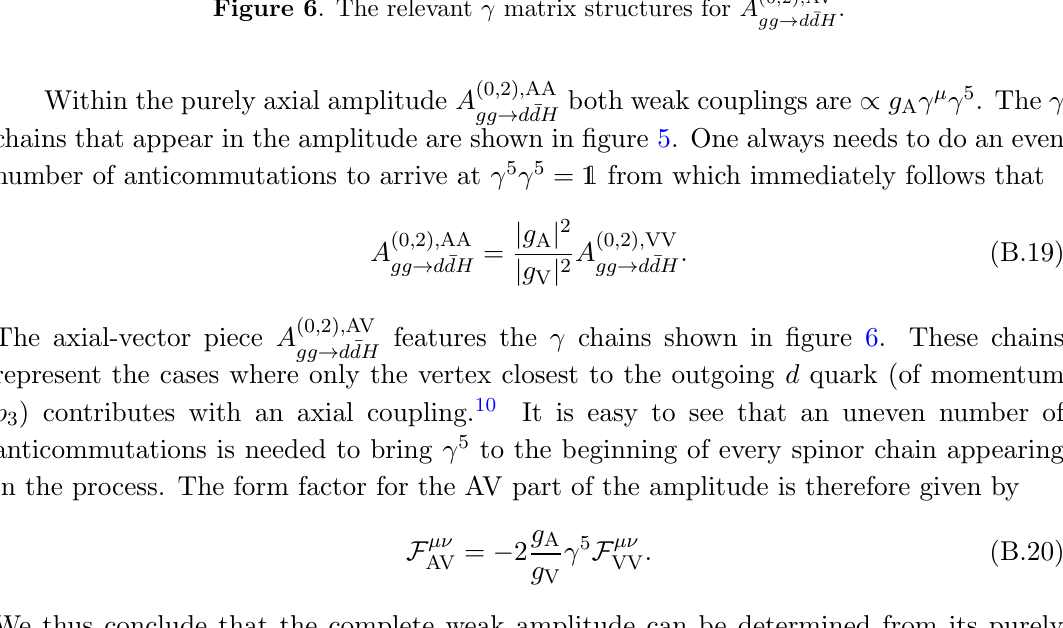
Figure 6 . The relevant (cid:13) matrix structures for A (0 ; 2) ; AV